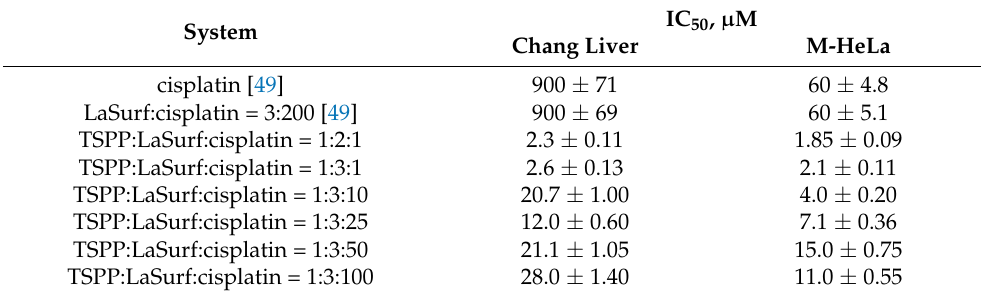
Table 2. Values of the half-maximal inhibitory concentration IC 50 (calculated for cisplatin concentra- tion) in Chang liver and M-Hela cells for ternary TSPP − LaSurf–cisplatin systems. IC 50 , µ M System Chang Liver M-HeLa cisplatin [49] 900 ±